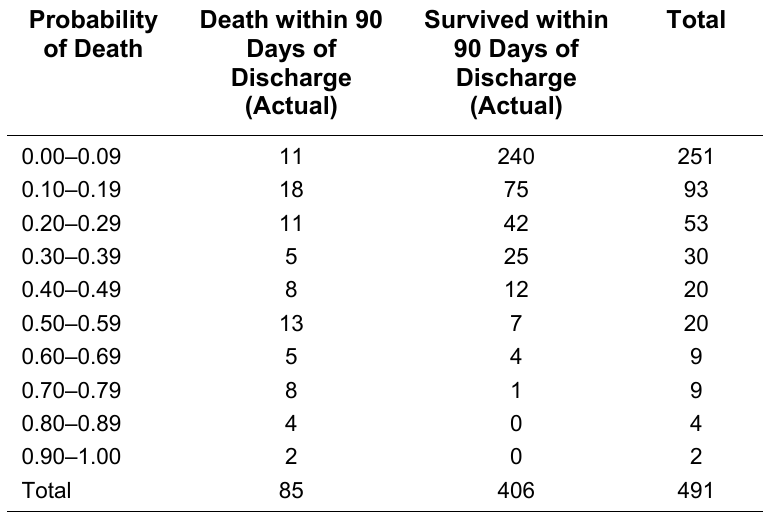
Probability Distribution of Outcomes for 90-Day Logistic Regression Model — Administrative and Clinical Data Testing